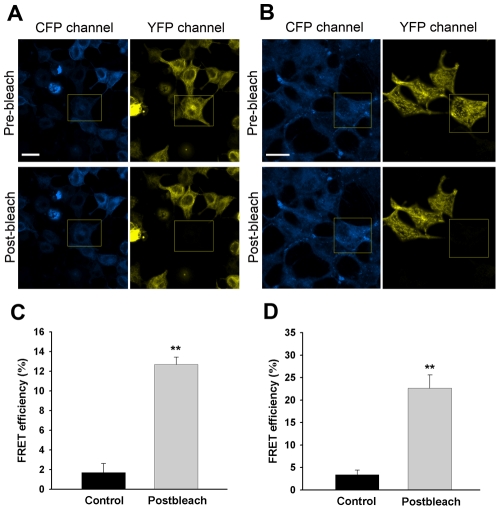
FRET measured by donor dequenching after acceptor photobleaching in HEK293T cells cotransfected with eCFP-STIM1 and eYFP-STIM1.Part A: CFP-STIM1 images before and after photobleaching of the acceptor within the indicated region (Left column); acceptor YFP-STIM1 intensities before and after photobleaching in the indicated region (Right column). Part B: images acquired near the cell adhesion surface after stimulation of cells with 2 µM TG. Part C: the bar graphs representing FRET efficiency (E) are from 20 independent experiments such as those in part A. The efficiency was determined by the acceptor photobleaching method and was measured only in the (acceptor) bleached area. Cells outside the bleached region were used as controls. Part D: the bar graphs representing FRET efficiency (E) are from the 20 independent experiments in part B. All data are represented as mean±S.D. The significance levels indicated are as follows: **P<0.001. Scale bars, 20 µm.